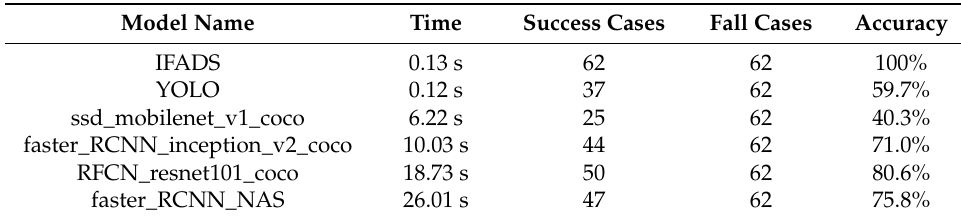
Table 4. The results of a falling person detected by the machine learning methods.